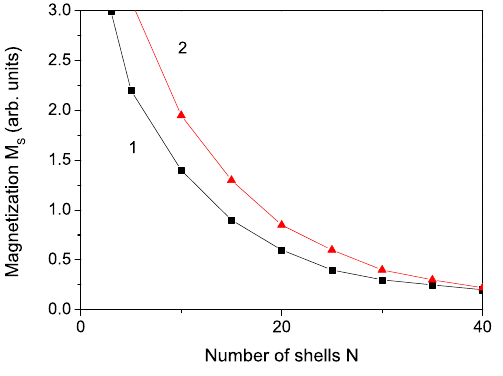
Figure 1. Dependence of the magnetization M s on the size in CCO for T = 300 K, J s 1,2,3 = 1.2 J b 1,2,3 (1) and 1.3 J b 1,2,3